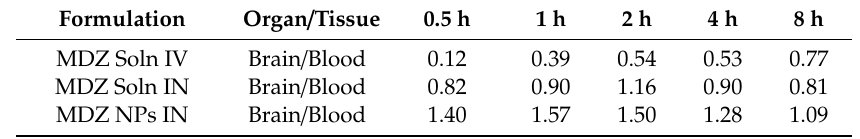
Table 5. Brain / blood ratio for MDZ at di ff erent time intervals in Wister rats.